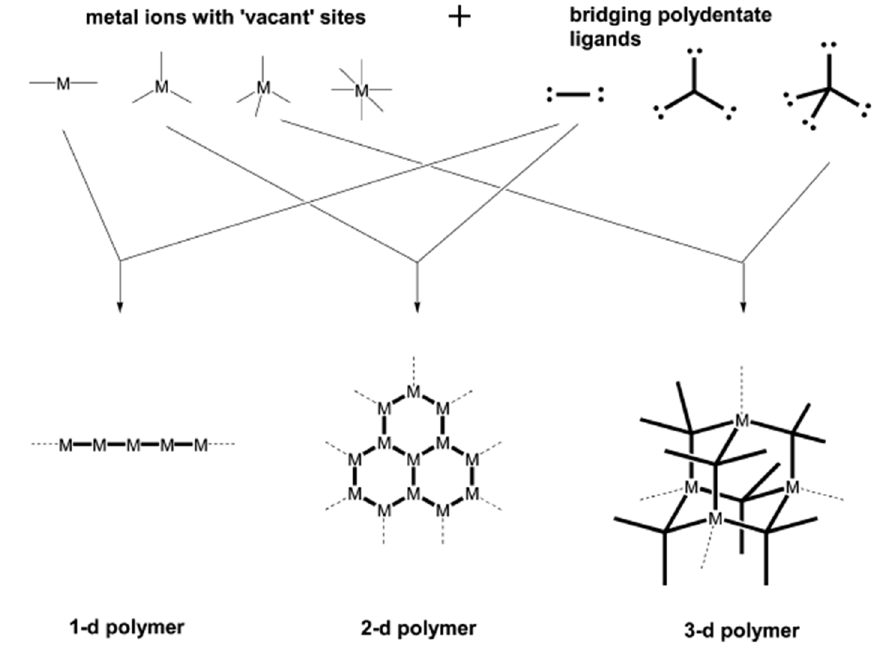
Figure 1. Building block principle behind formation of coordination polymers.